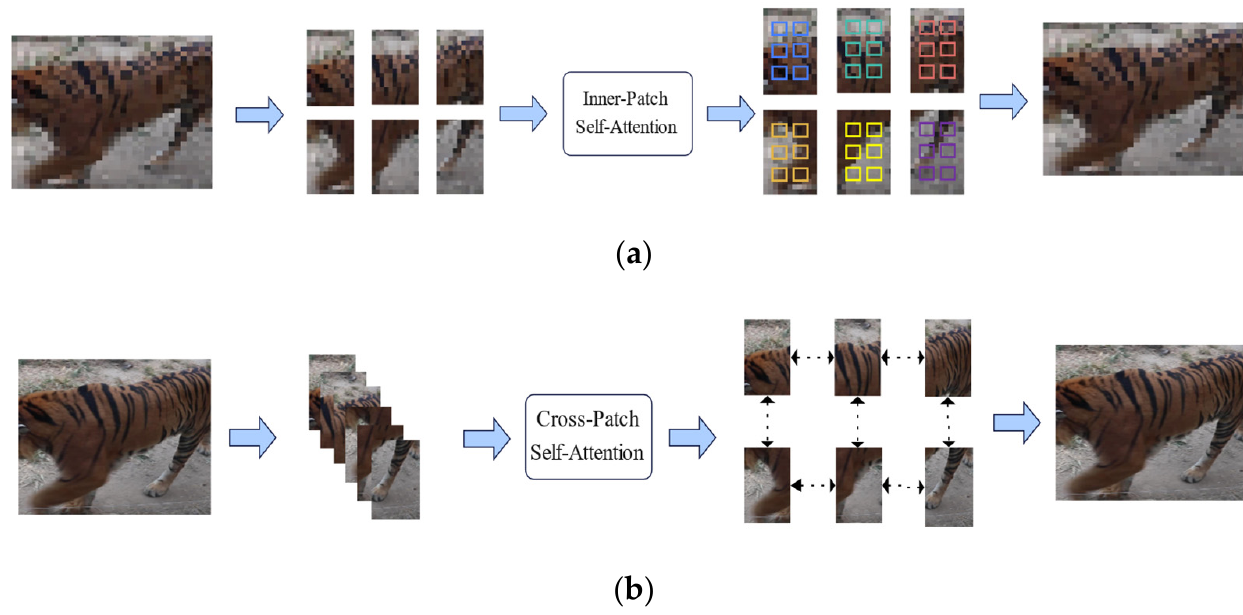
global information of the whole image, and then reshaped these patches of the channel into the original shape.